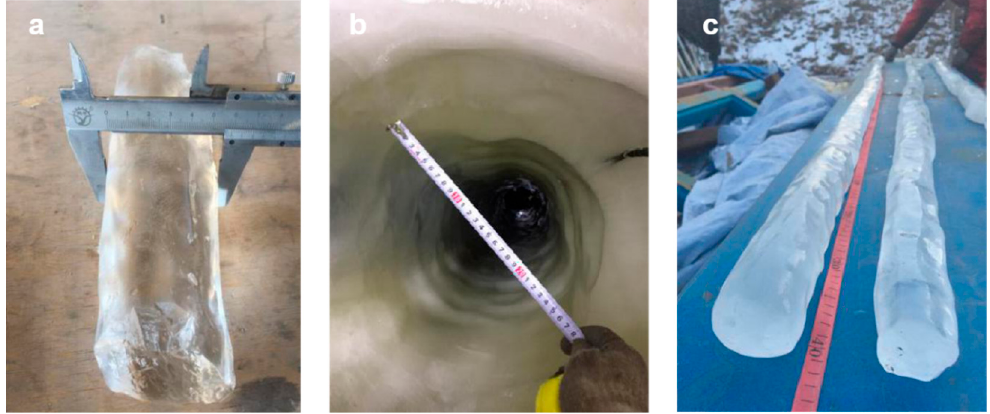
Figure 9. Measurements for: ( a ) diameter of ice core; ( b ) diameter of borehole; ( c ) length of ice core. Three tests (run No. 1, 2, 3) were performed at different temperatures (50/60/70 °C) of hot water with nearly constant flow rate (55 L/min). Results from these tests indicated 50 °C was the optimal temperature to get ice cores of good quality with larger diameters. During the five subsequent runs